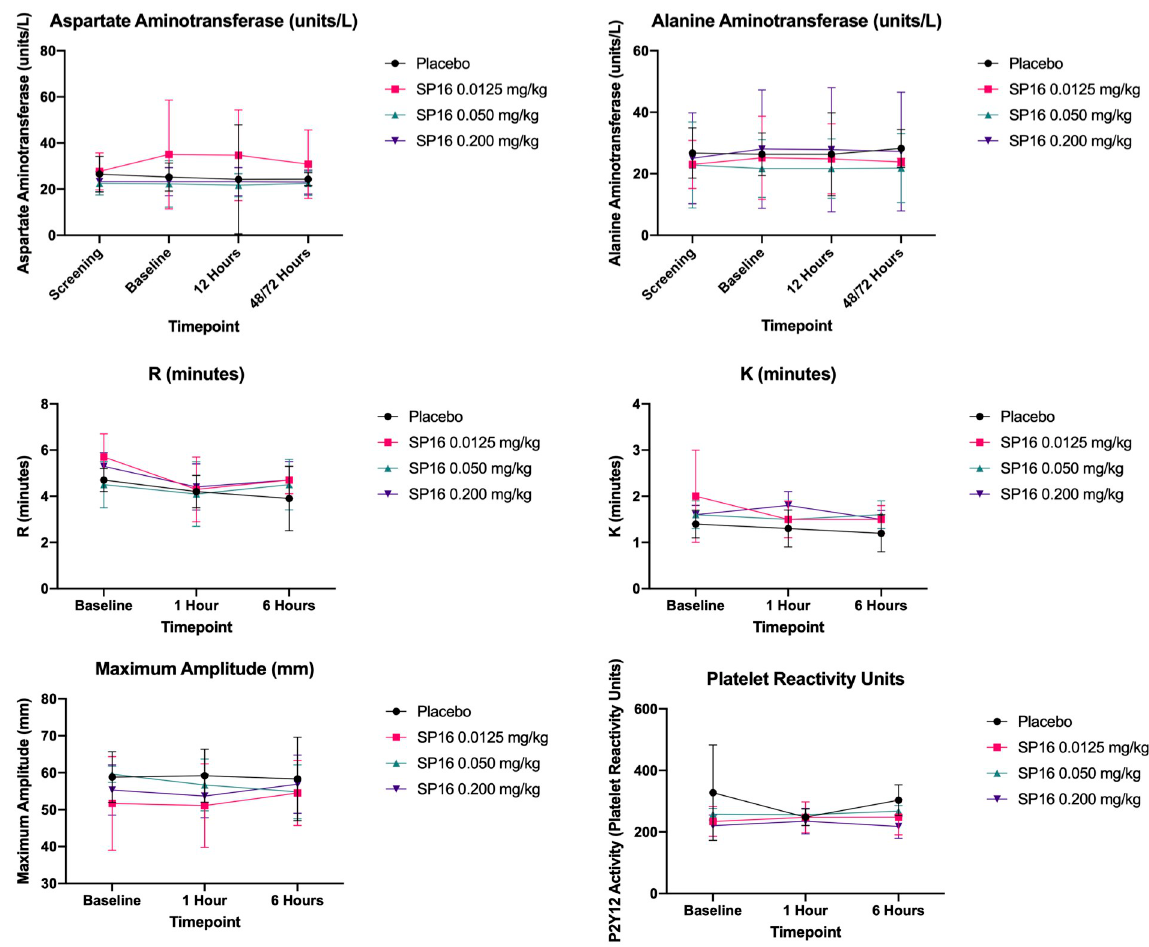
Fig 4. Effects of SP16 on key biochemical safety parameters.